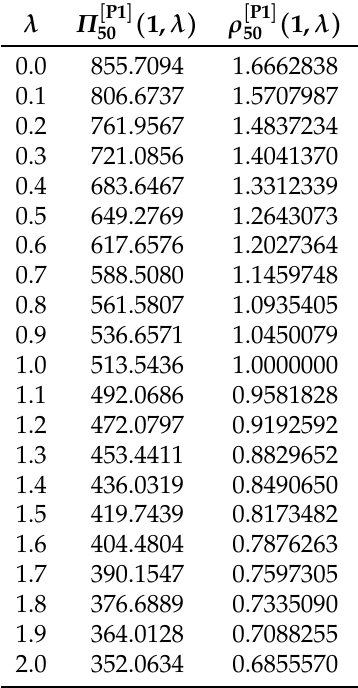
Table 13. Product P1 (stand-alone); x = 50, b = 100.